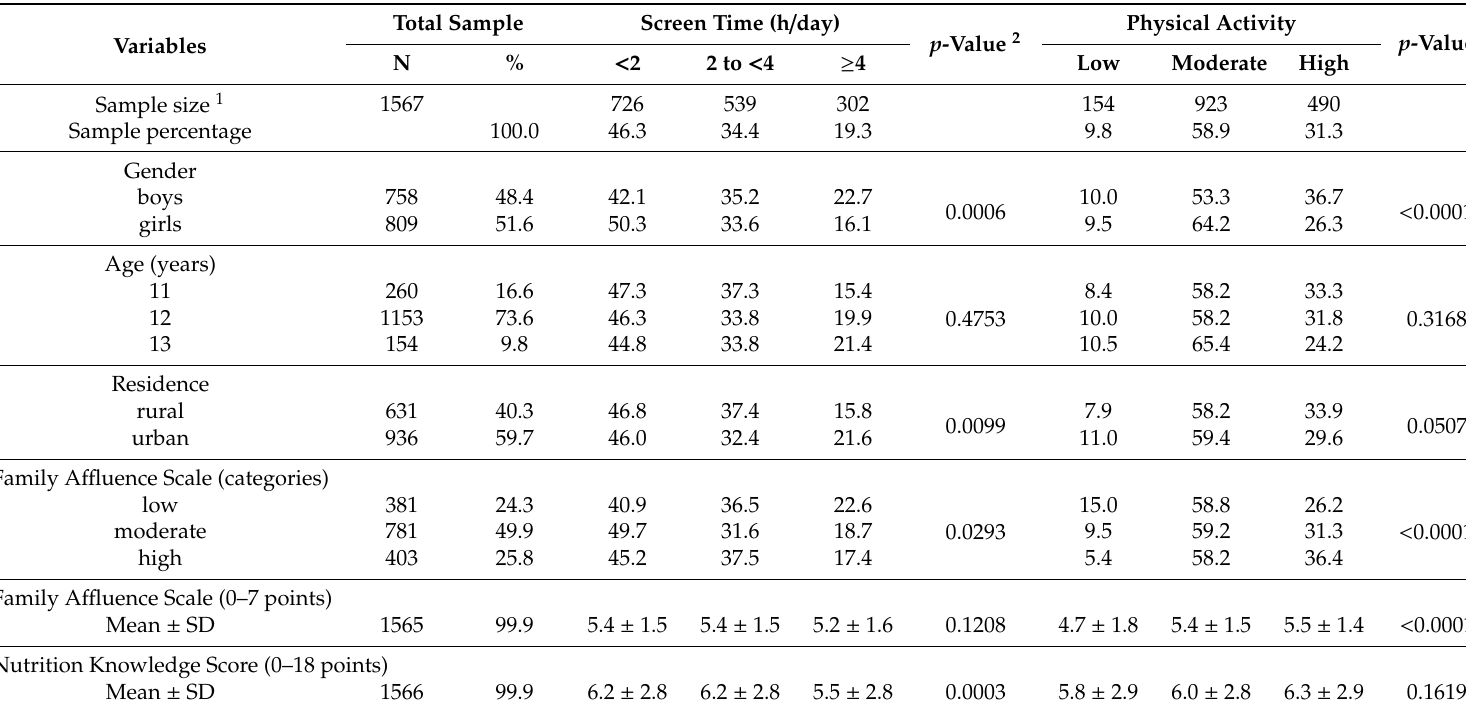
Table 2. Characteristics of participants (% N or mean ±